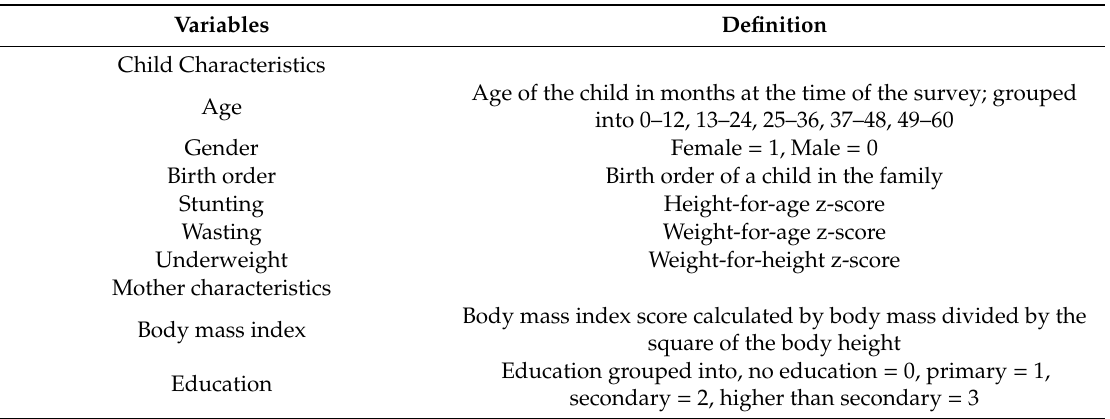
Table 1. Definition of the variables used in this